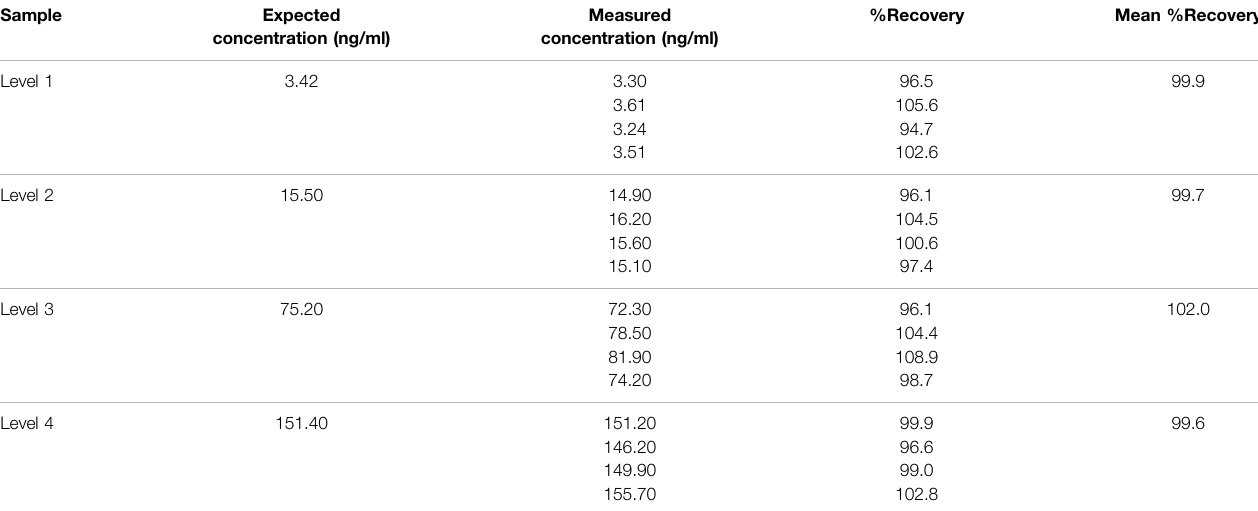
TABLE 1 | Mean % recoveries evaluated from four replicates for each level of concentration.